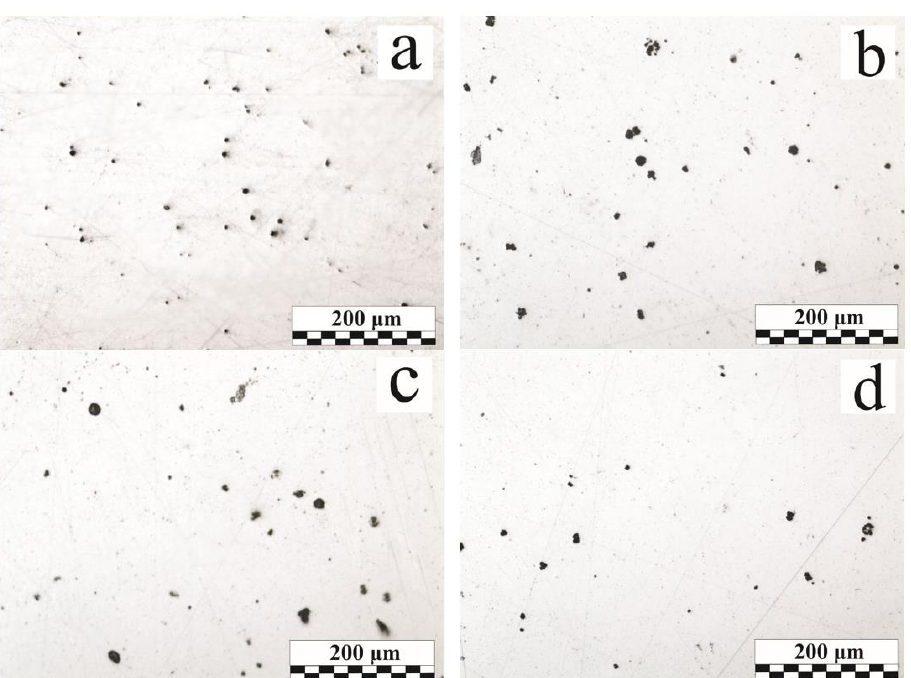
Figure 3. Weld cross-sections photographs: ( a ) bare sample, end; ( b ) OS-51-03 green, 95 microns, end; ( c ) OS-56-22, 185 microns, end; ( d ) OS-82-01, 160 microns, end.